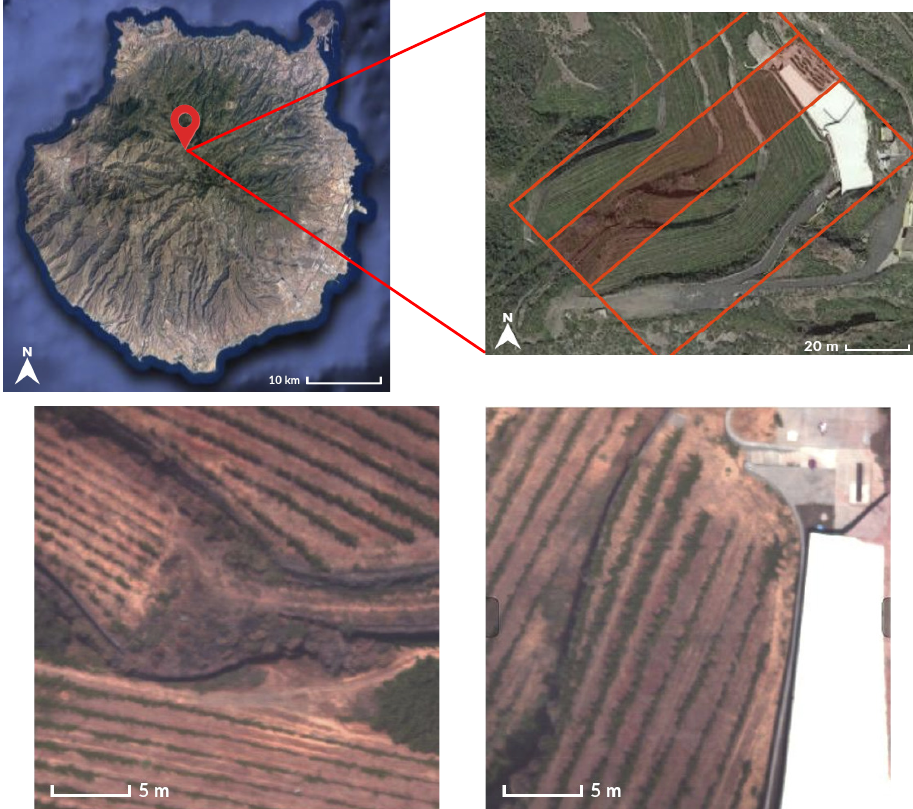
Figure 11. Google Maps pictures of the vineyard areas sensed during the second flight campaign. False RGB representations of the hyperspectral images employed in the